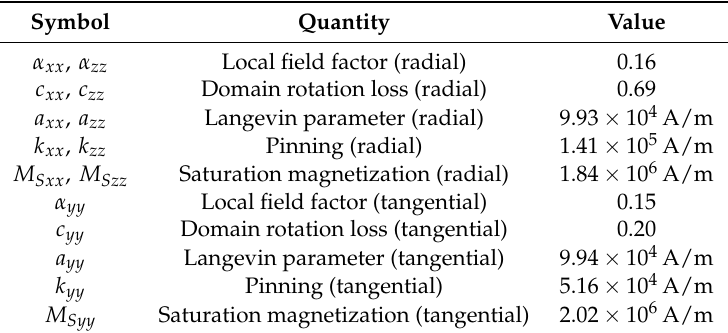
Table 2. Jiles–Atherton tensor elements for anisotropic FeCrCo